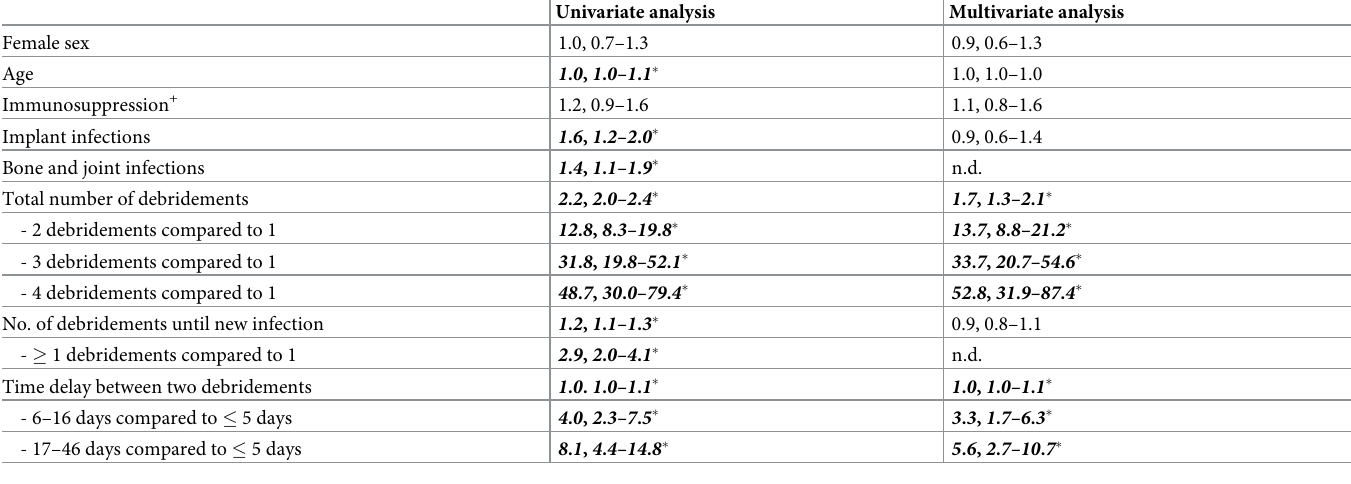
Table 5. Univariate and multivariate associations with resistant new SSI’s (Logistic regression analysis; results expressed as odds ratios with 95% confidence intervals)